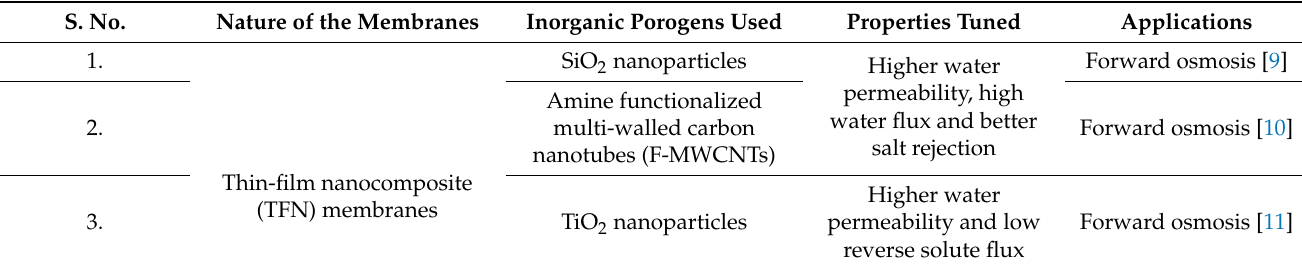
Table 2. Different inorganic nanoparticles used in thin film nanocomposite membranes. S.